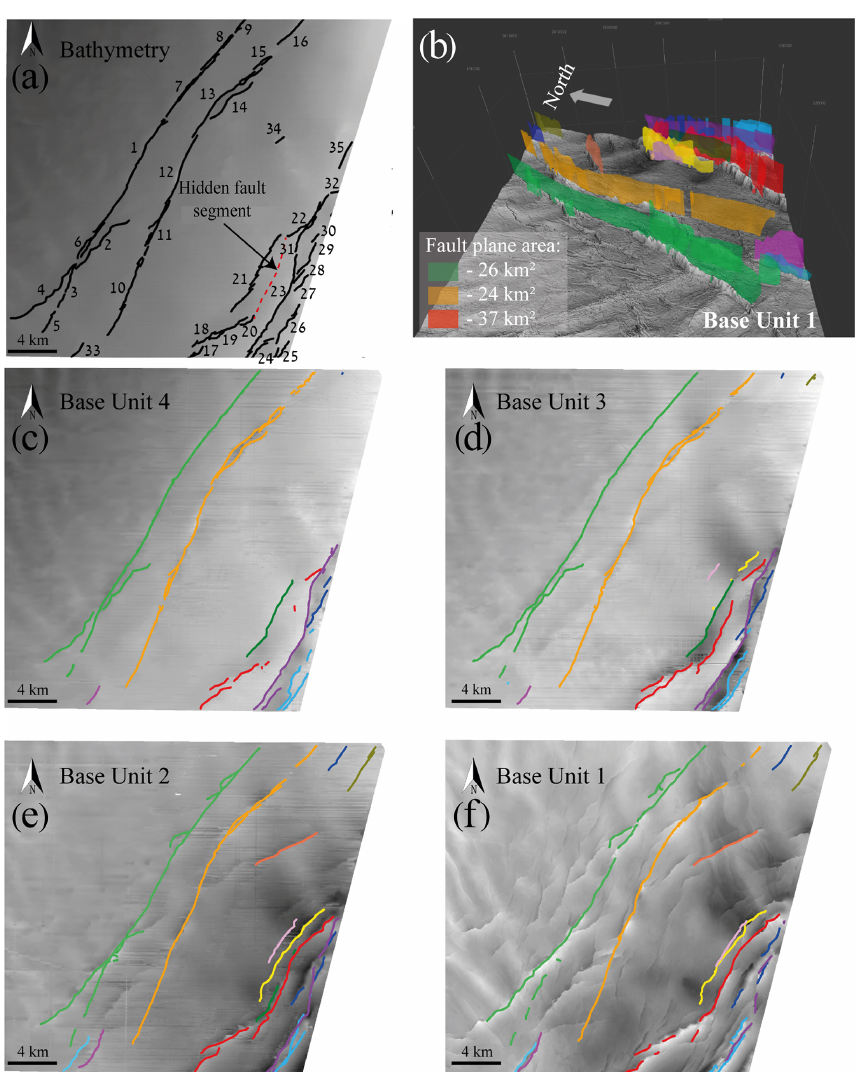
Figure 7. Subsurface mapping of fault planes. (a) 35 faults segments rupturing the seabed in the eastern part of the Sara–Myra survey (location in Fig. 1). (b) A 3D view of fault planes illustrating that the 35 fault segments at the seabed belong to seven major faults (each fault represented by one color). An example of some fault plane area measurements. (c–f) Structural maps of four subsurface horizons (base units 4–1), each with faults crossing it (same colors as in panel b ). Note the hidden fault segment (dashed red line in panel a ), which does not disrupt the seabed but may rupture it in the